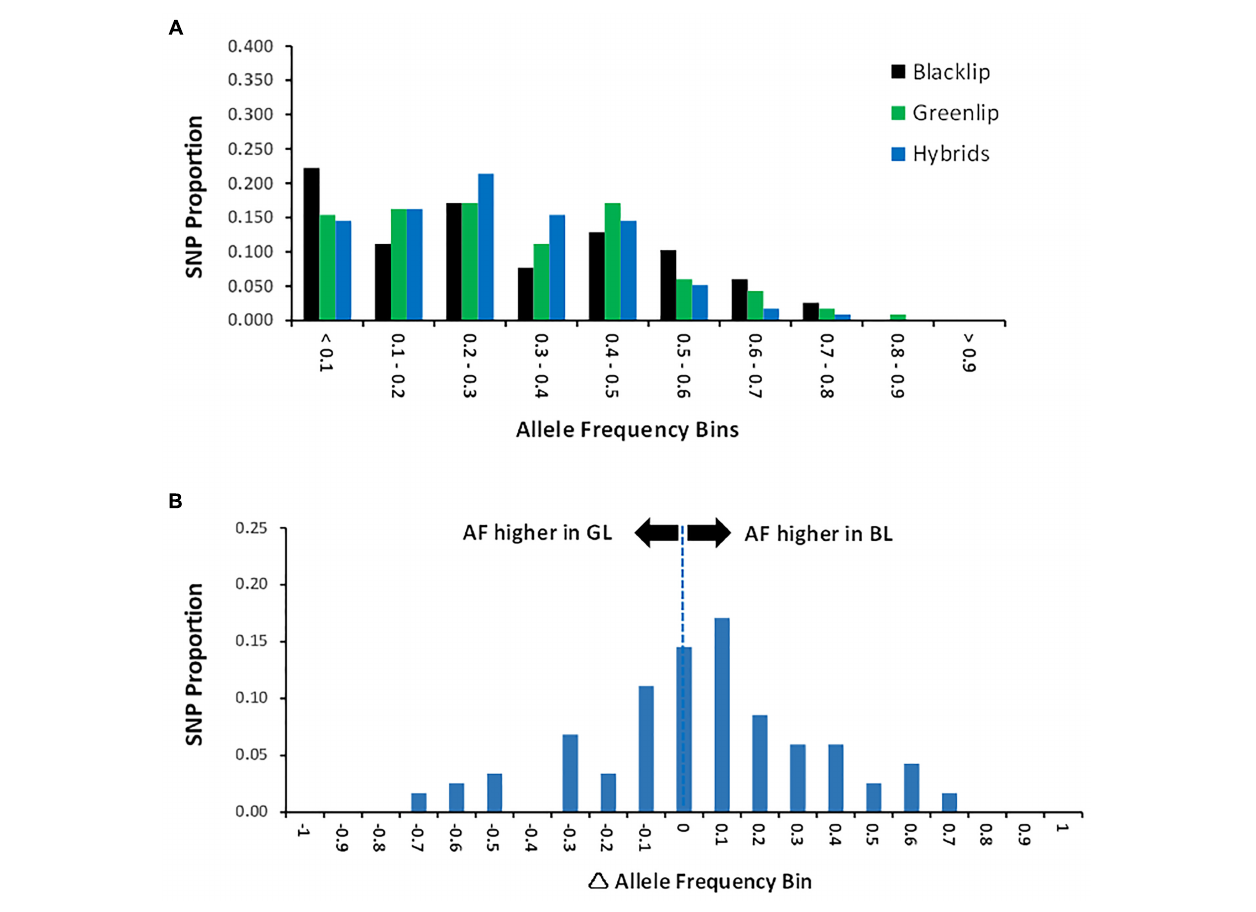
FIGURE 1 | Allele Frequency. (A) Allele frequency (AF) was estimated jointly across the three populations and the proportion of SNP is shown across 10 frequency bins. AF is higher than 0.5 when the minor allele in one population is the major allele in a separate population. (B) Allele frequency difference (AF (cid:49) ) was estimated for each SNP as the BL AF minus the GL AF. Positive AF (cid:49) values indicate SNP with higher allele frequency in BL compared with GL. The distribution of values is given in frequency